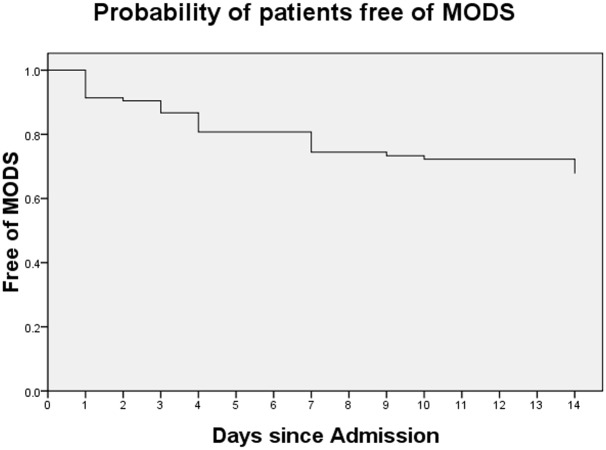
Probability of patients free of MODS.